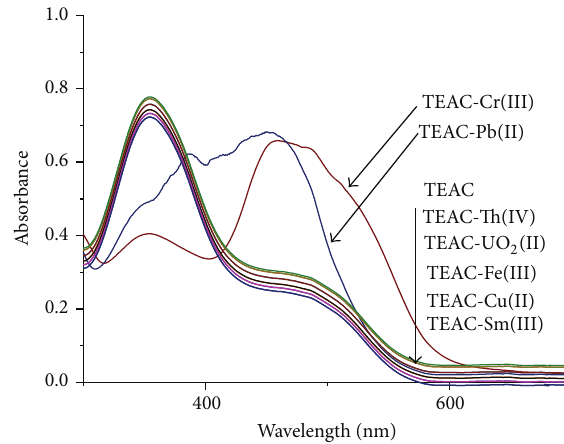
Figure 6: Effect of metal ions on the change in the absorbance of TEAC-Cr(III) and TEAC-Pb(II) complexes with MeOH + H 2 O as solvent and pH =